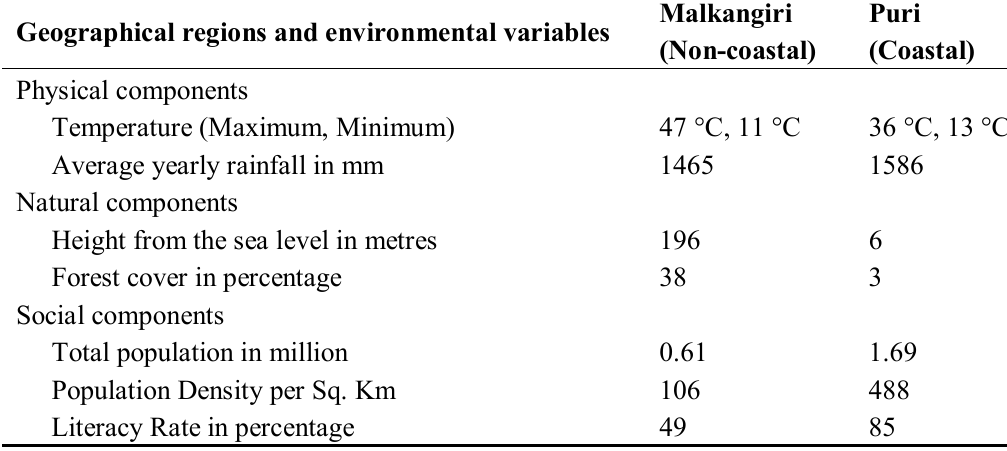
Table 1. Environmental variables of the study setting, Malkangiri and Puri,